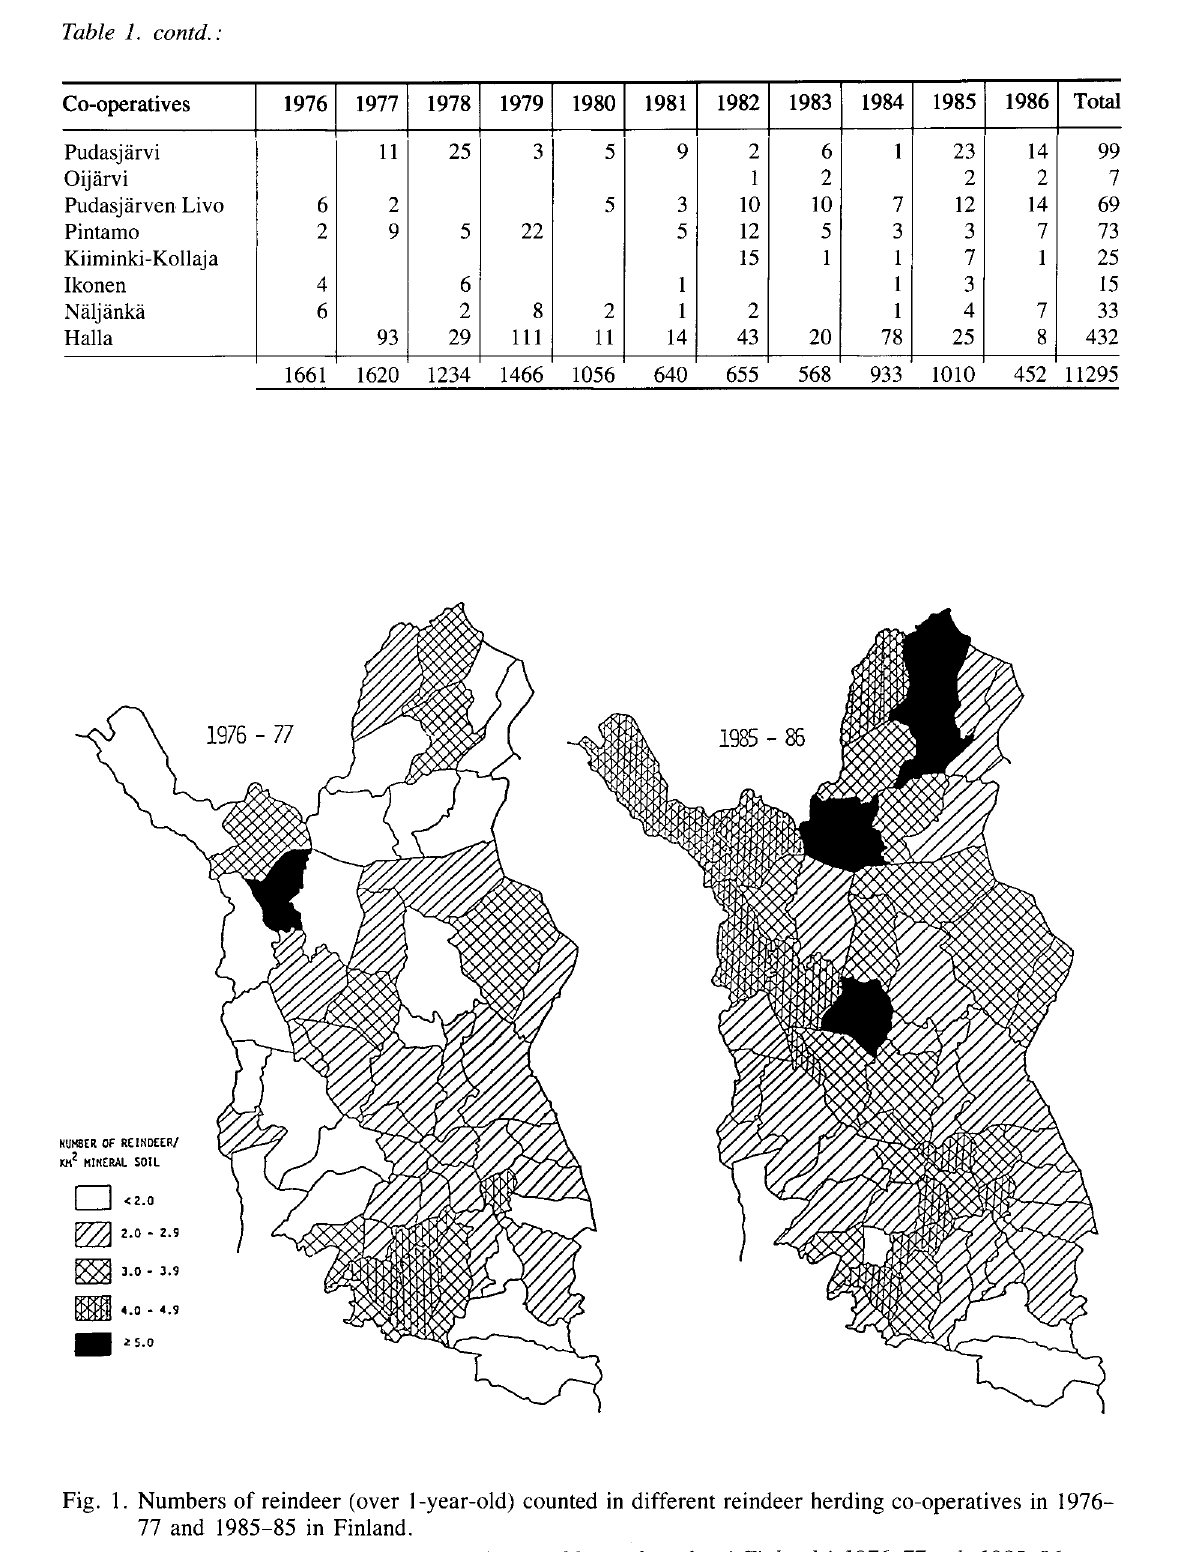
Fig. 1. Numbers of reindeer (over 1-year-old) counted in different reindeer herding co-operatives in 1976¬ 77 and 1985-85 in Finland. Fig. 1. Antalet renar (over 1 år gamla) råknat i olika renbeteslag i Finland i 1976-77 och